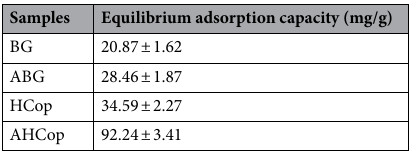
Table 4. Equilibrium adsorption capacity of BG, ABG, HCop, and AHCop at 25